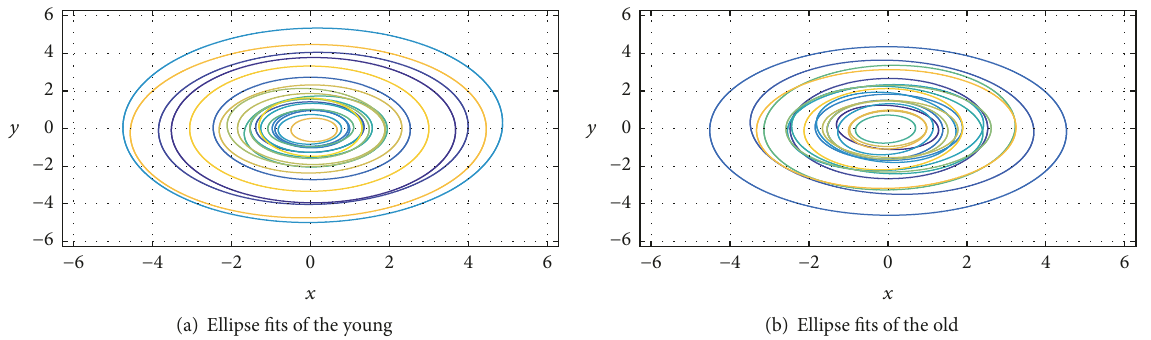
Figure 4: Direct ellipse fits for trajectories of (a) the young and (b) the elderly participants at band s low 4